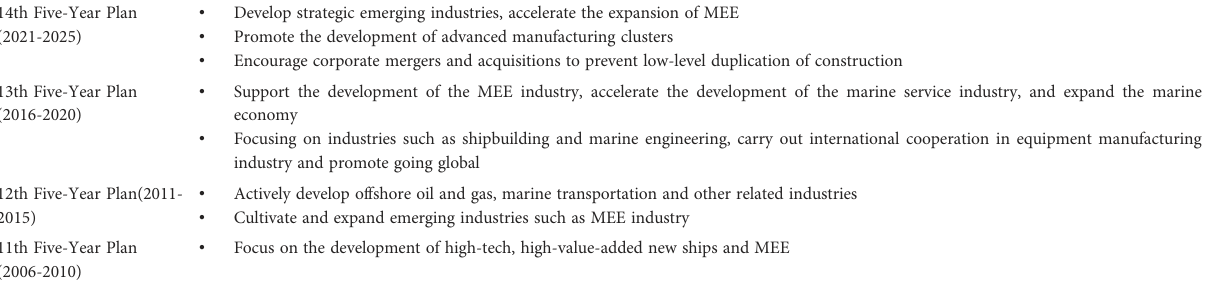
TABLE 1 MEE industry development plans in NPC ’ s Five-Year